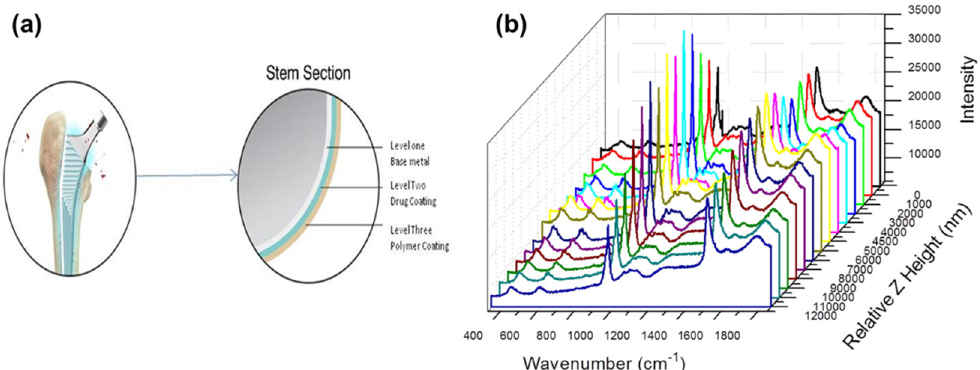
Figure 13. ( a ) Schematic diagram of the stem section showing the polymer/drug bilayer, ( b ) plots of GS and PLGA Raman spectra from the confocal Raman spectrum as the laser moves through the Z height [64]. Reprinted with permission from ref. [64] . © 2013 American Chemical Society. The ester group bands at 1770 cm − 1 represent PLGA, while the C–O–C band’s asym- metrical stretching at 1046 cm − 1 . According to this graph, the peak height rises as the laser